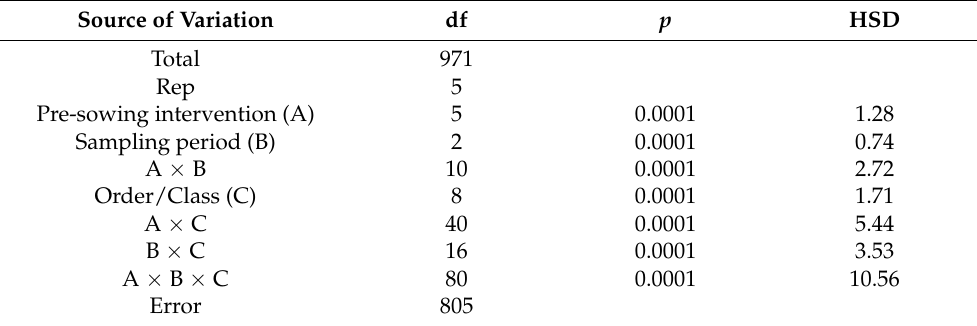
Table 8. Factorial analysis of the total capture of different orders/classes of soil fauna.